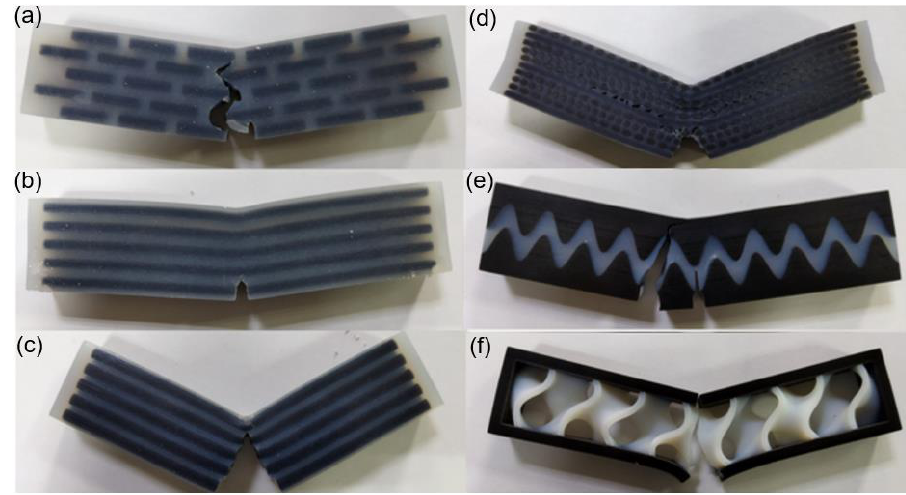
Figure 19. Experimental results of the six bionic structures. ( a ) Layered ( b ) Columnar ( c ) Tubular ( d ) Helical ( e ) Sutured ( f ) Sandwich.